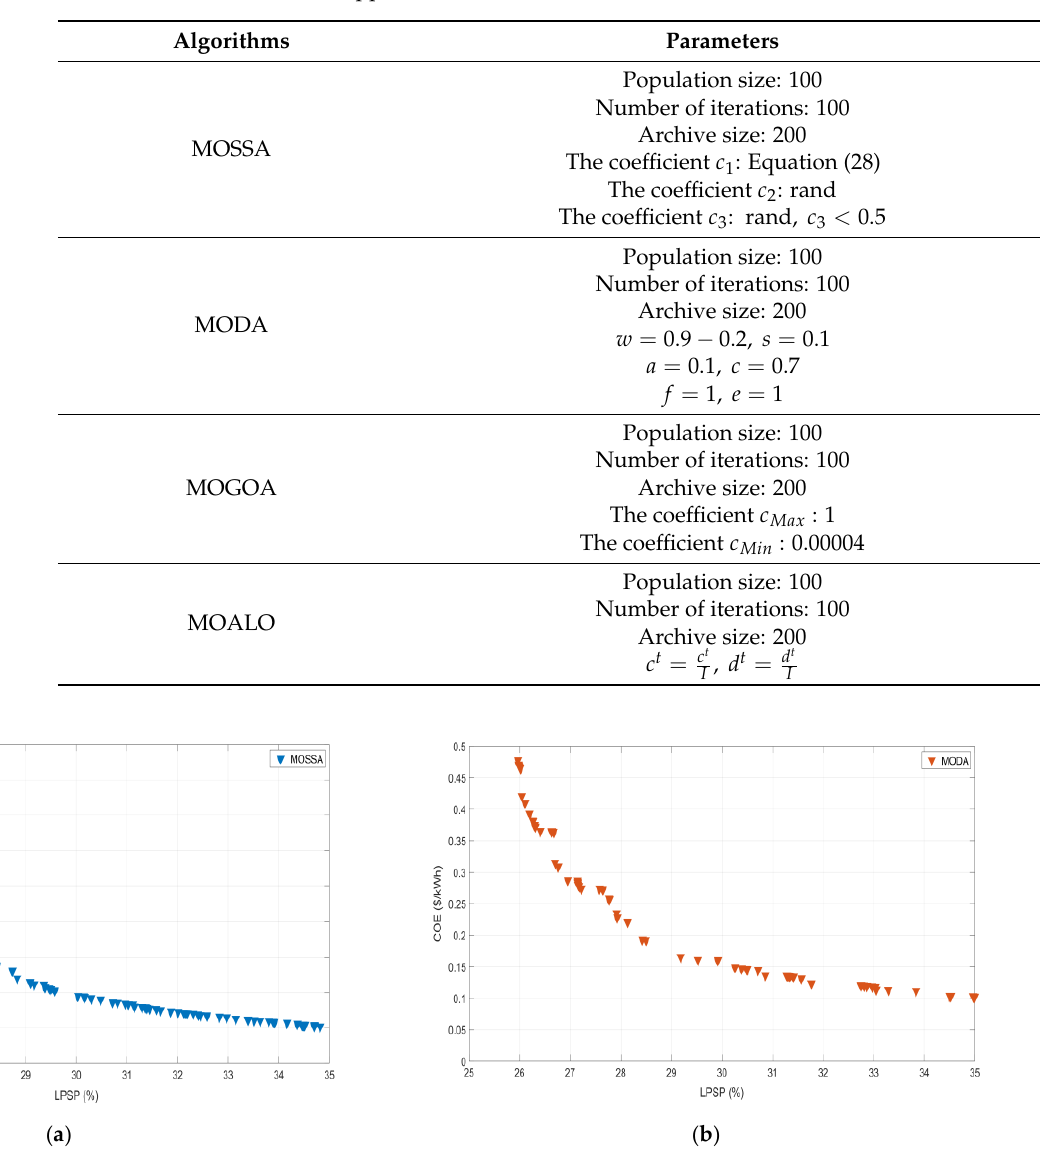
Table 5. Parameters for each approach.